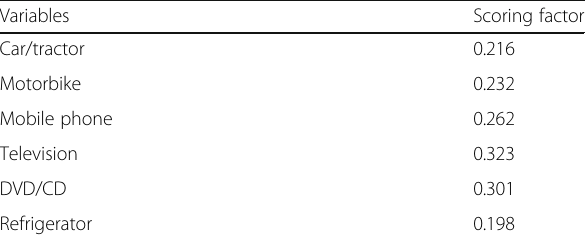
Table 1 Scoring factors for wealth index variables Variables Scoring factor